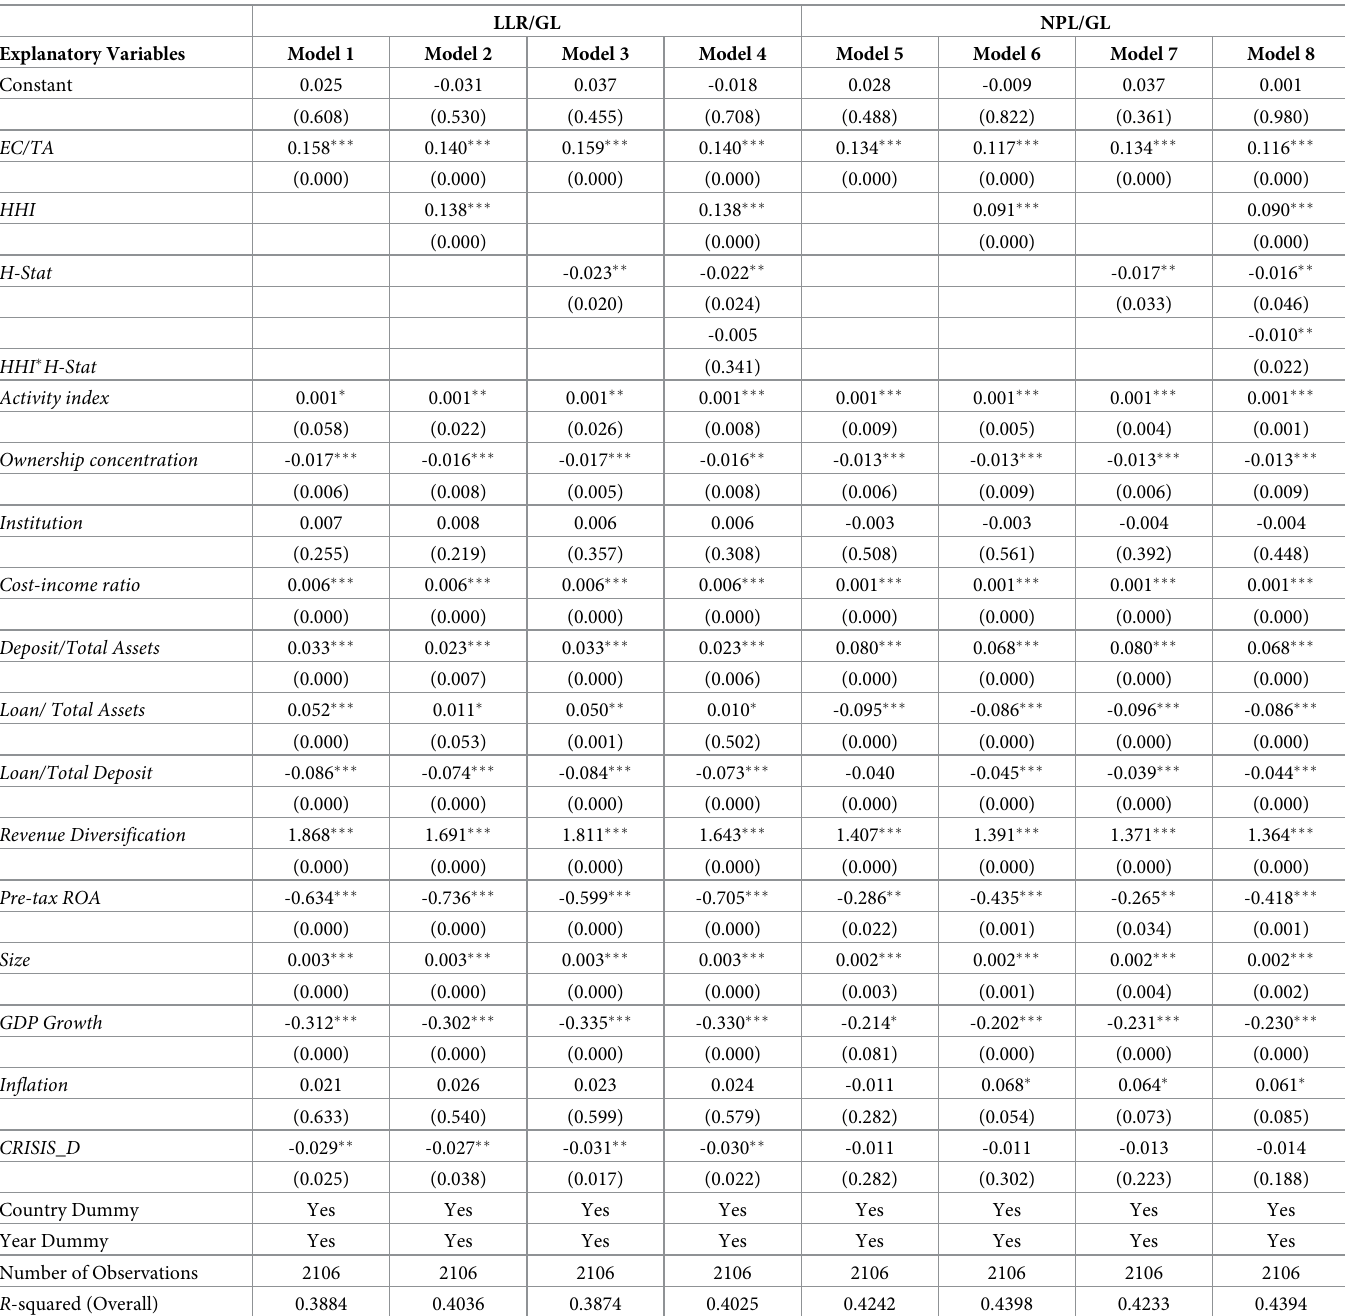
Table 7. Panel regressions of competition and credit risk (CBs,